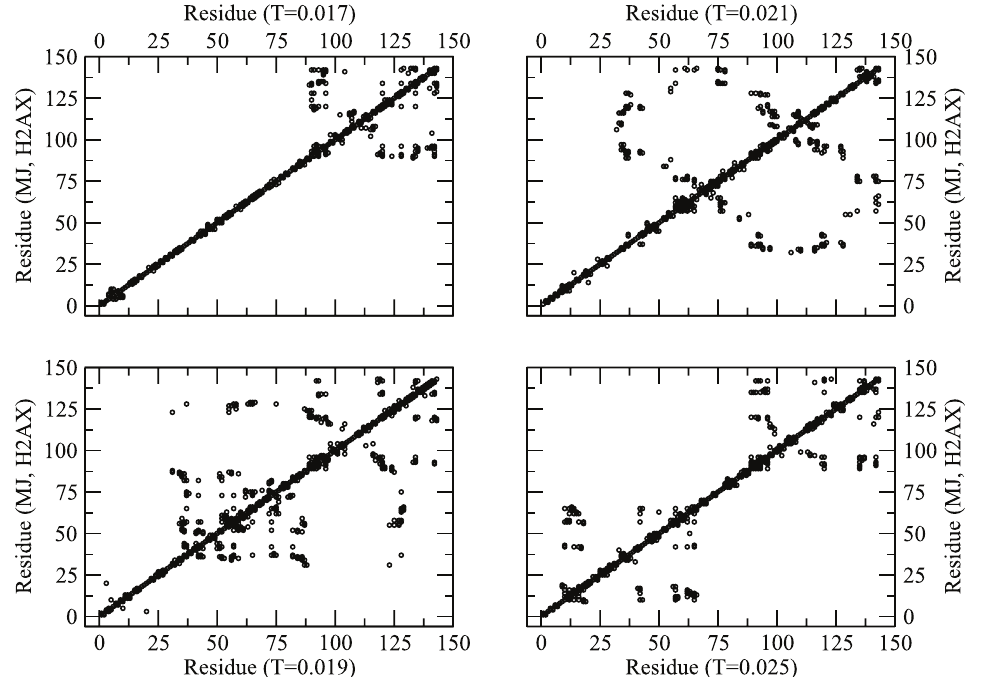
Figure 3. Residue map (neighboring residues along the contour within the range of interaction) of protein at different temperatures ( T=0.017–0.025 ) with the classical MJ potential. doi:10.1371/journal.pone.0064507.g003 structure factor with the wave vector, S(q) / q 2 1/ n , one can estimate the spatial distribution of residues in the protein by analyzing its radius of gyration ( R g ). The scaling of the radius of gyration of the protein chain with the number N of its nodes